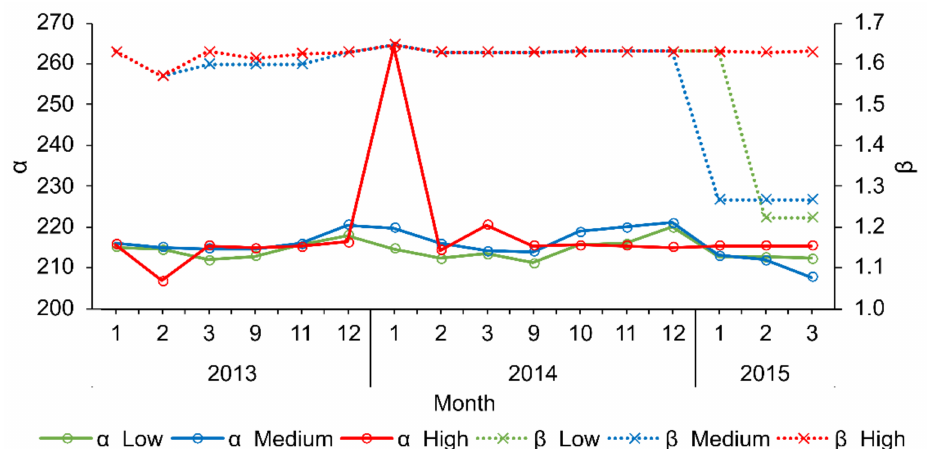
Figure 5. Trend plot of α (solid line with circle mark) and β (dash line with cross mark) at each month from January 2013 to March